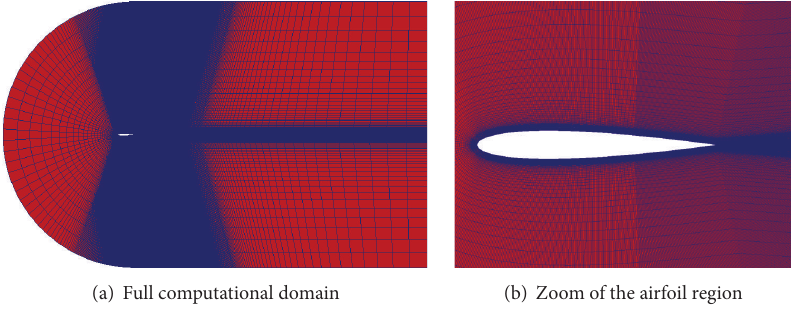
Figure 10: NACA 0012 airfoil. Computational grid.